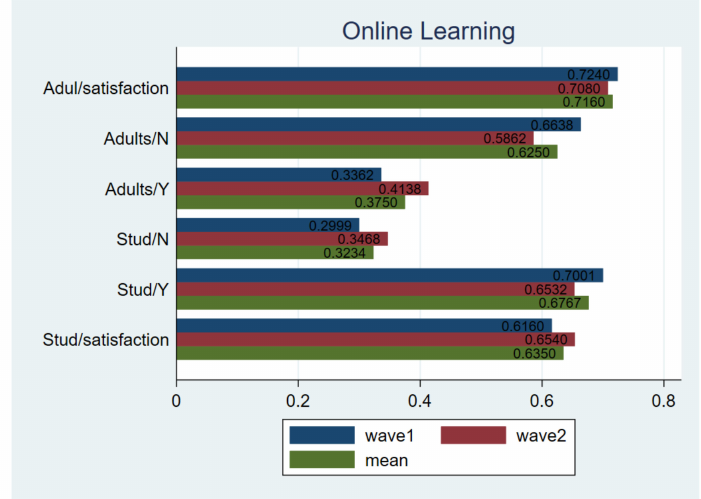
Figure 6. Comparing online learning. Notes: t -test for H 0 : equal variance assumed: t value = − 2.1440,